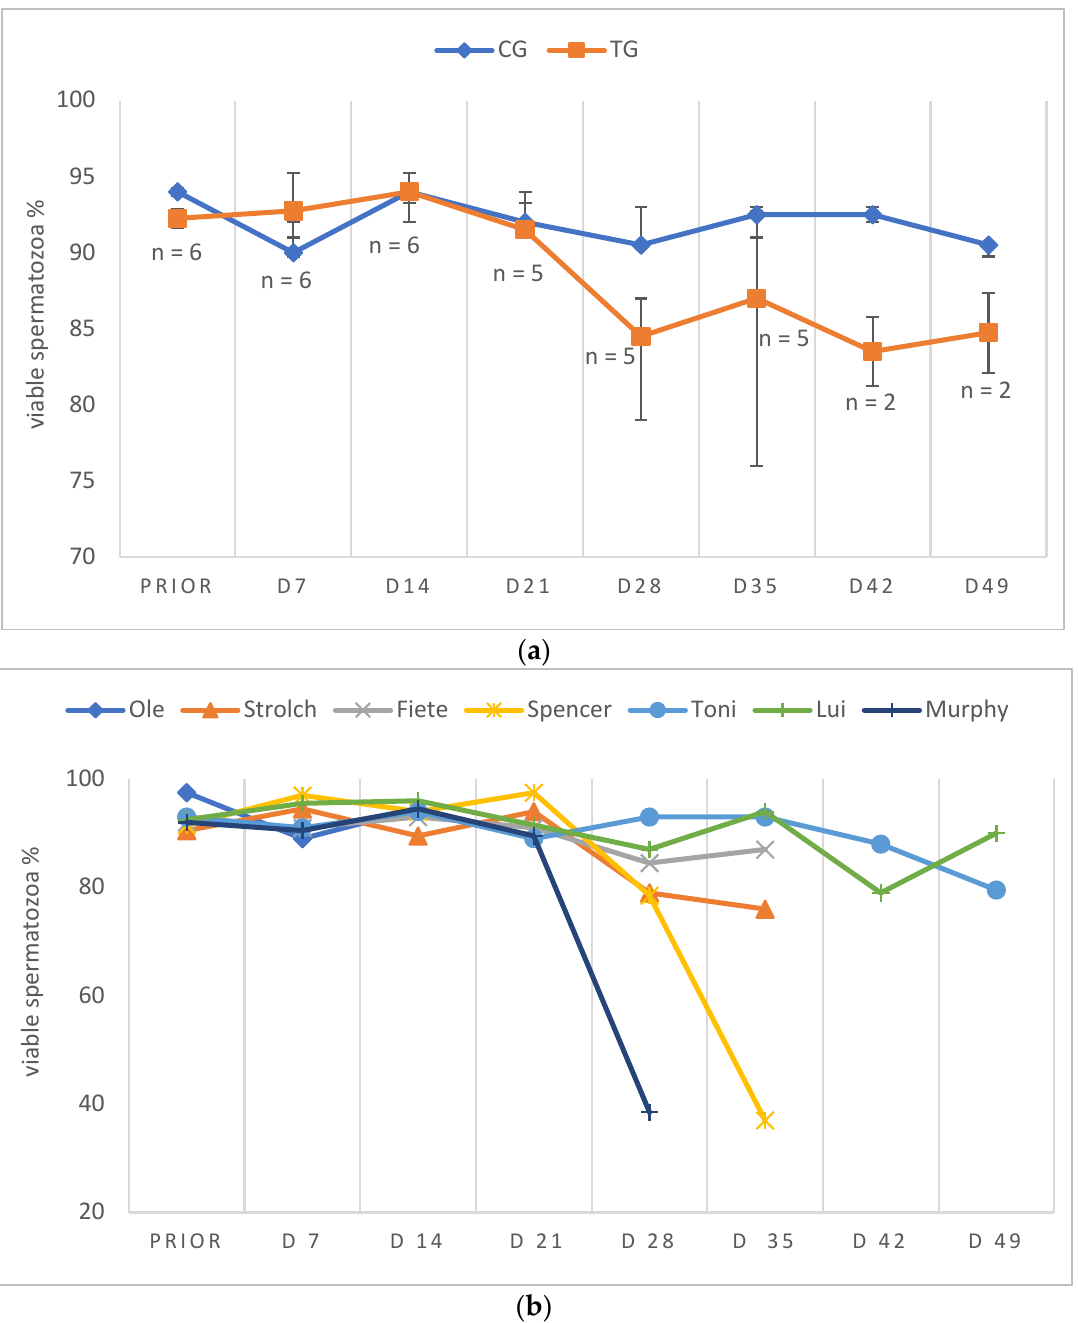
Figure 6. ( a ) Percentage of viable sperm given as median (Q1, Q3) over time of animals treated with a 4.7 mg deslorelin implant (TG, n = 6, if not indicated otherwise) and saline-treated control animals (CG, n = 3). “Prior” indicates “prior to treatment”. ( b ) Percentage of viable sperm given as individual courses of animals treated with a 4.7 mg deslorelin implant (TG, n = 7) over time. “Prior” indicates “prior to treatment”.